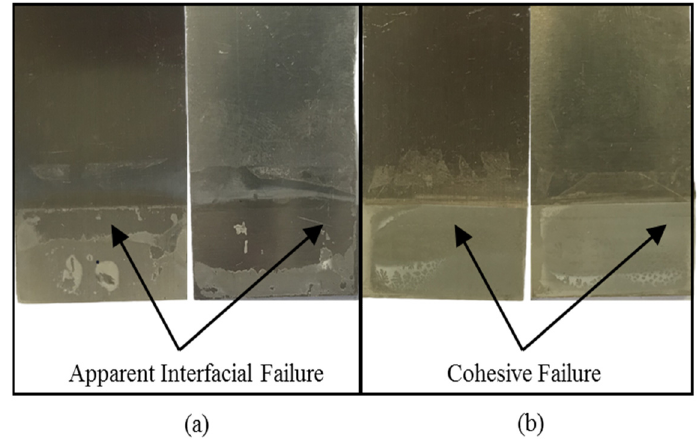
Figure 8. Fracture morphologies of the samples: ( a ) untreated, ( b ) laser scanning.